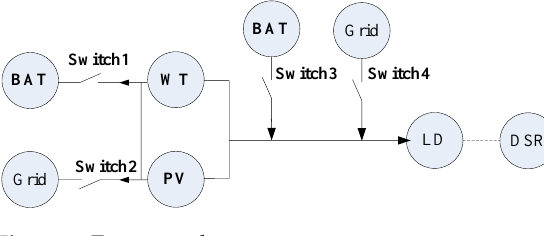
Figure 6. Energy exchange sequence.